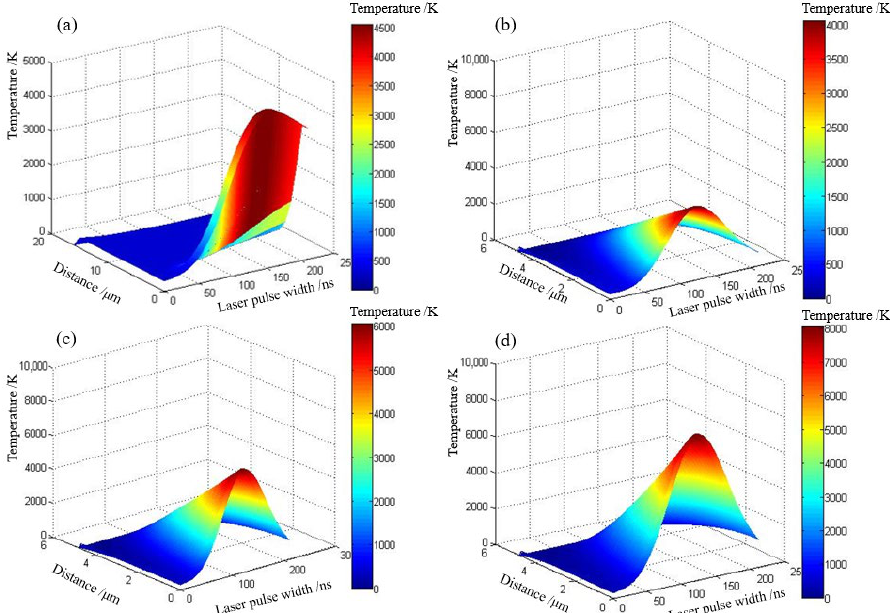
Figure 16. Temperature changes in the pulsed fiber laser dressing bronze material and diamond. ( a ) Bronze material, laser power density: 1.68 × 10 8 W/cm 2 ; ( b ) Diamond, laser power density: 1.68 × 10 8 W/cm 2 ; ( c ) Diamond, laser power density: 2.52 × 10 8 W/cm 2 ; ( d ) Diamond, laser power density: 3.36 × 10 8 W/cm 2 .